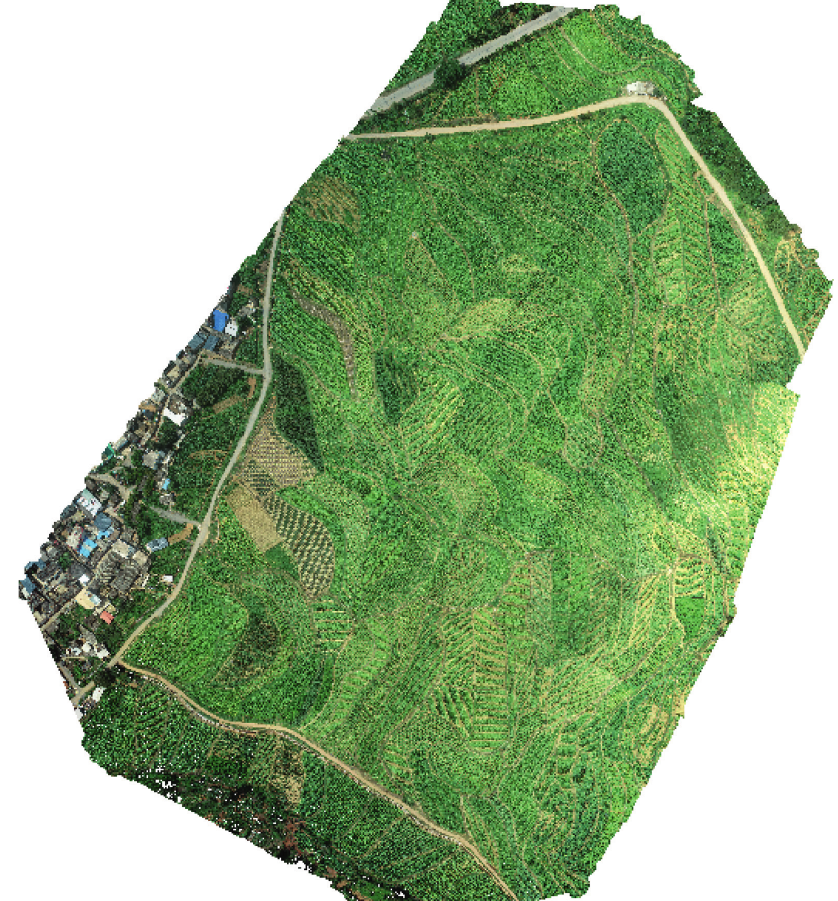
Figure 3: Thumbnail of case data.